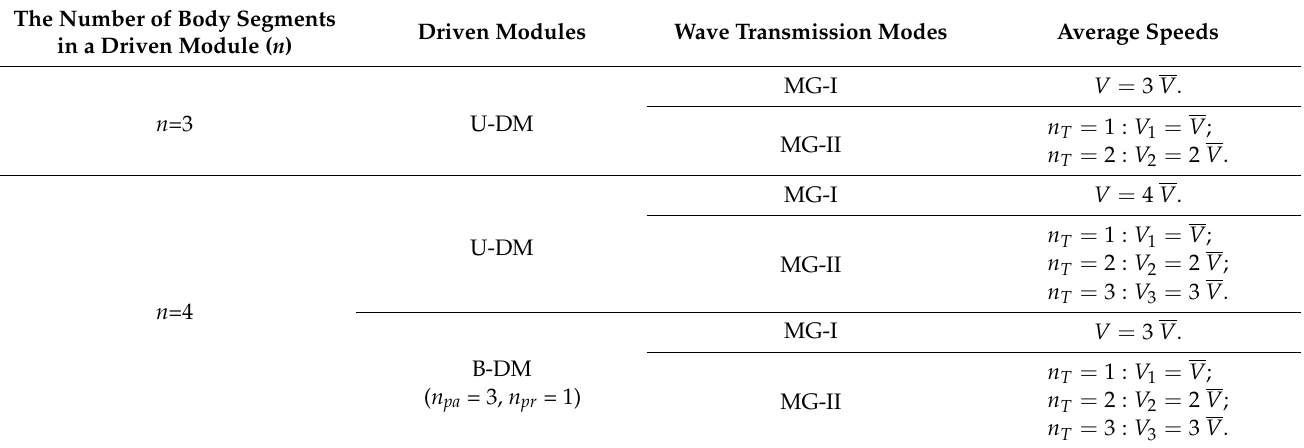
Table 2. The average speeds when k = 1. The Number of Body